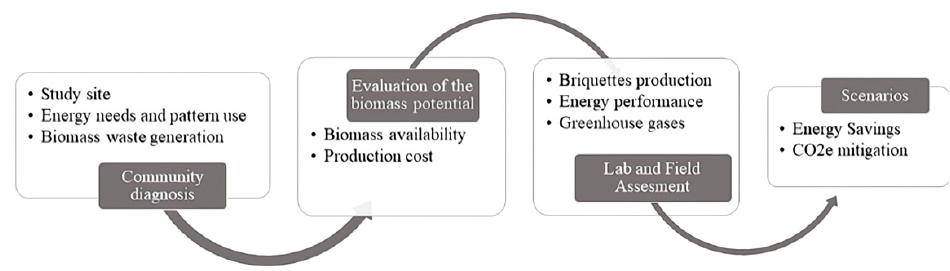
Figure 1. Comprehensive analysis of the production of briquettes from biomass residues